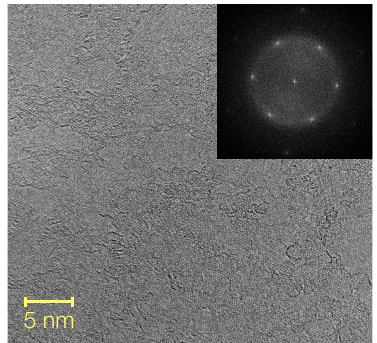
Figure 7. (Color online) TEM image of SLG after 180 keV Xe 40 + irradiation. Some residual contamination can be observed on an otherwise intact graphene sheet. No single ion-induced defects can be observed. The inset shows a FFT of the